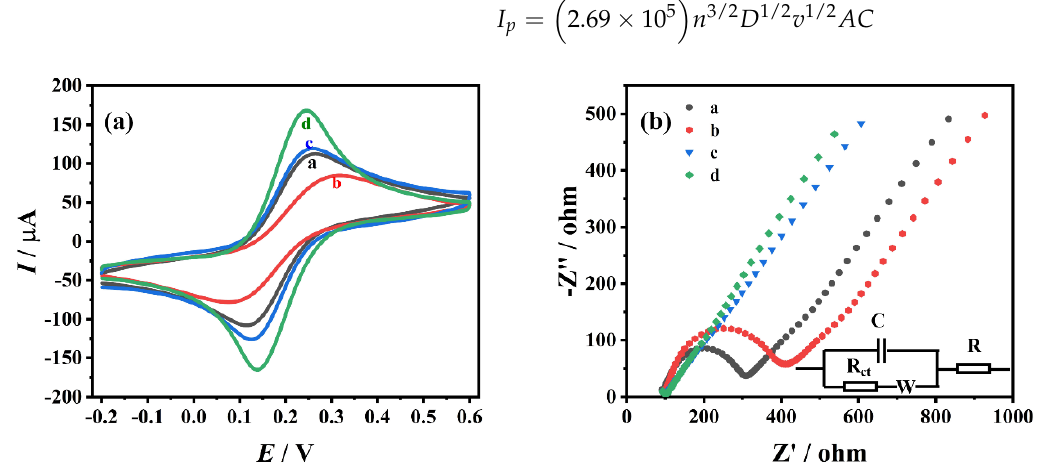
Figure 3. Cyclic voltammetry ( CV) diagrams ( a ) and Nyquist plots ( b ) obtained on different elec- trodes in a solution of 5 mM K 3 [Fe(CN) 6 ] 3 − /4 − and 0.1 M KCl (a: GCE, b: ZrO 2 /GCE, c: CS − MWCNTs/GCE, d: ZrO 2 − CS −